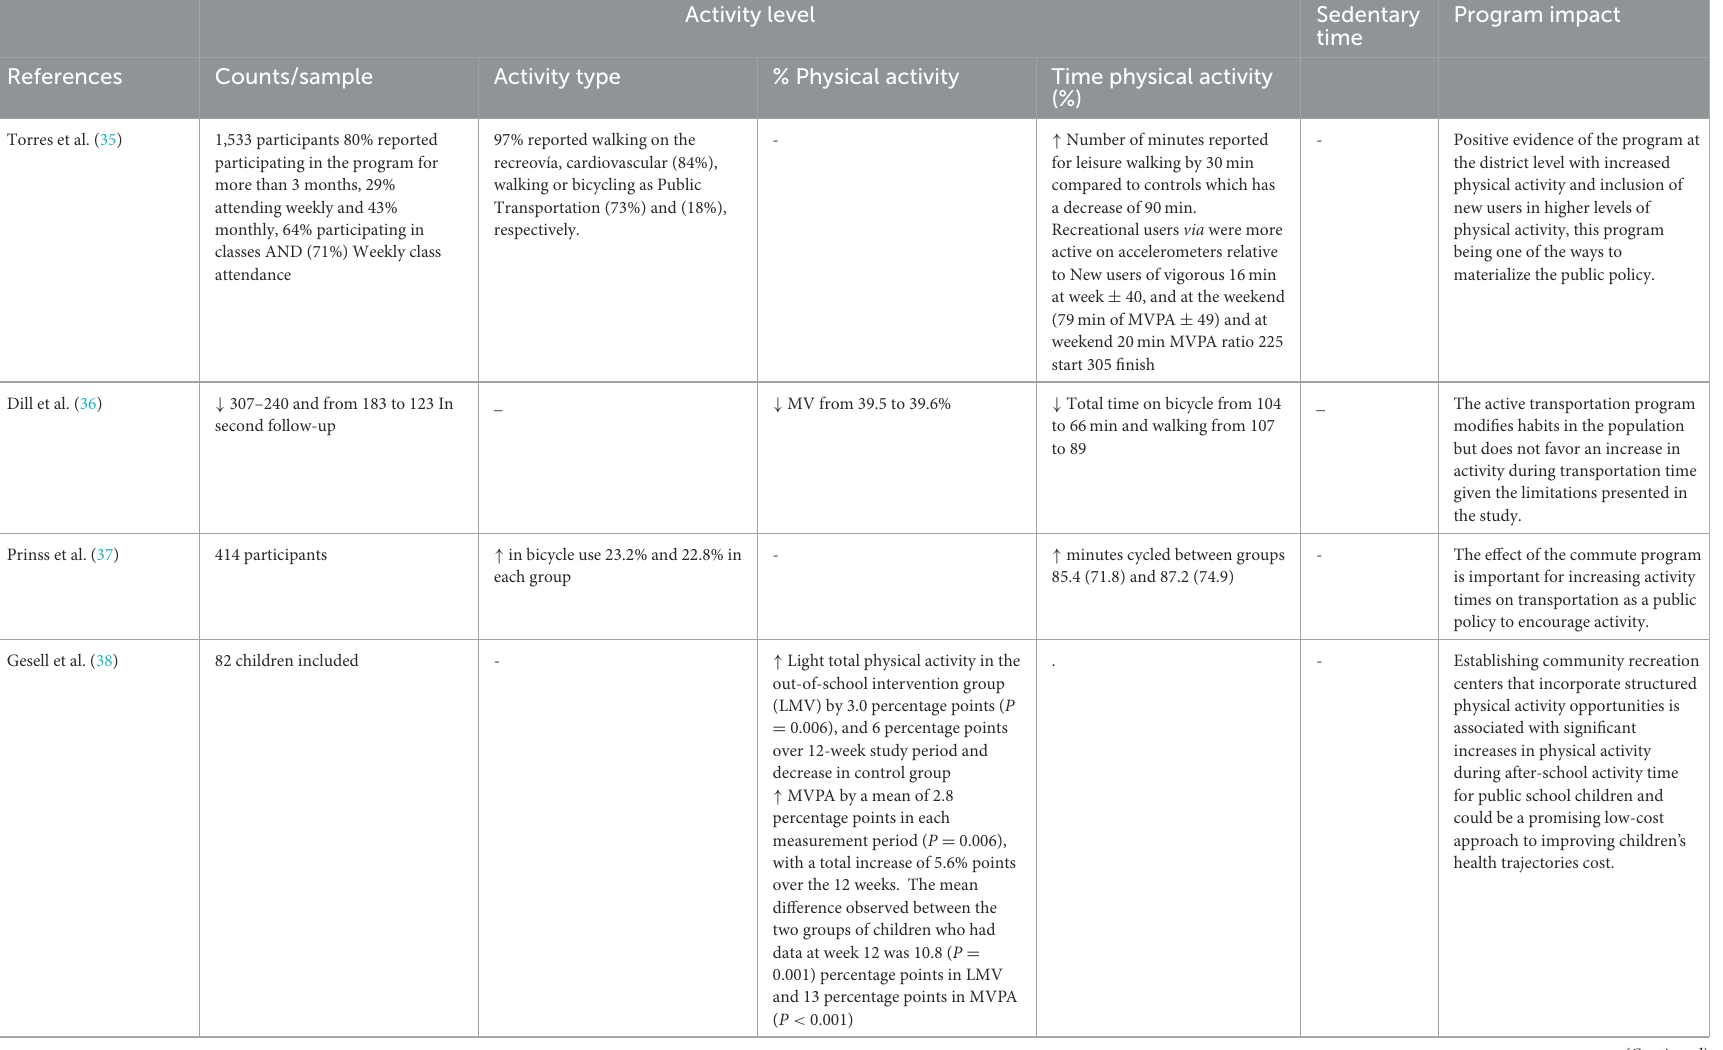
TABLE 3 Effectiveness of the